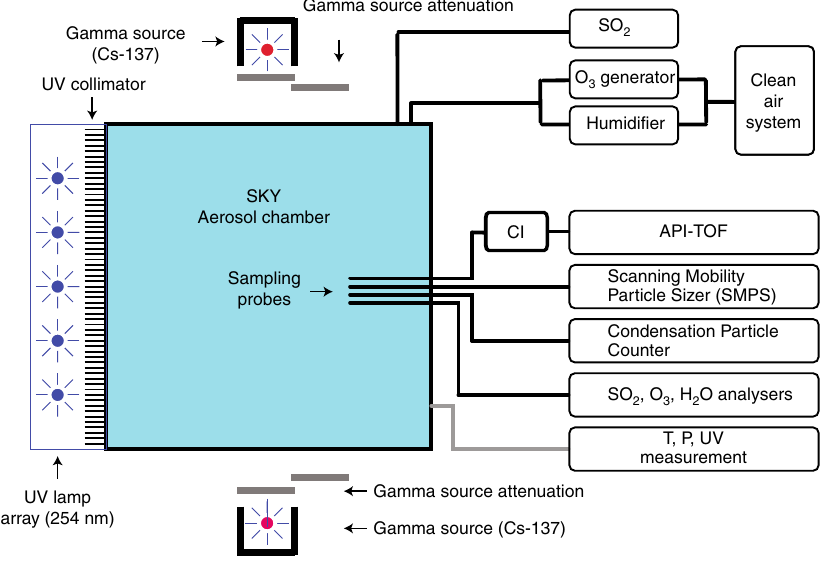
Fig. 6 The experimental